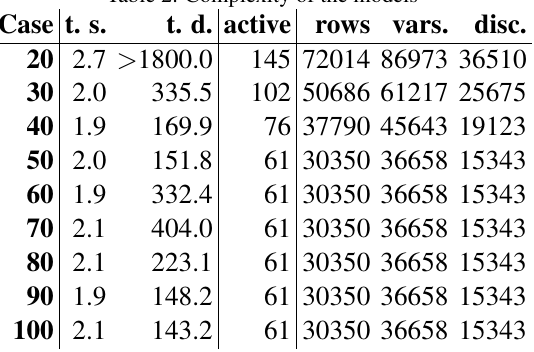
Table 2. Complexity of the models Case t.